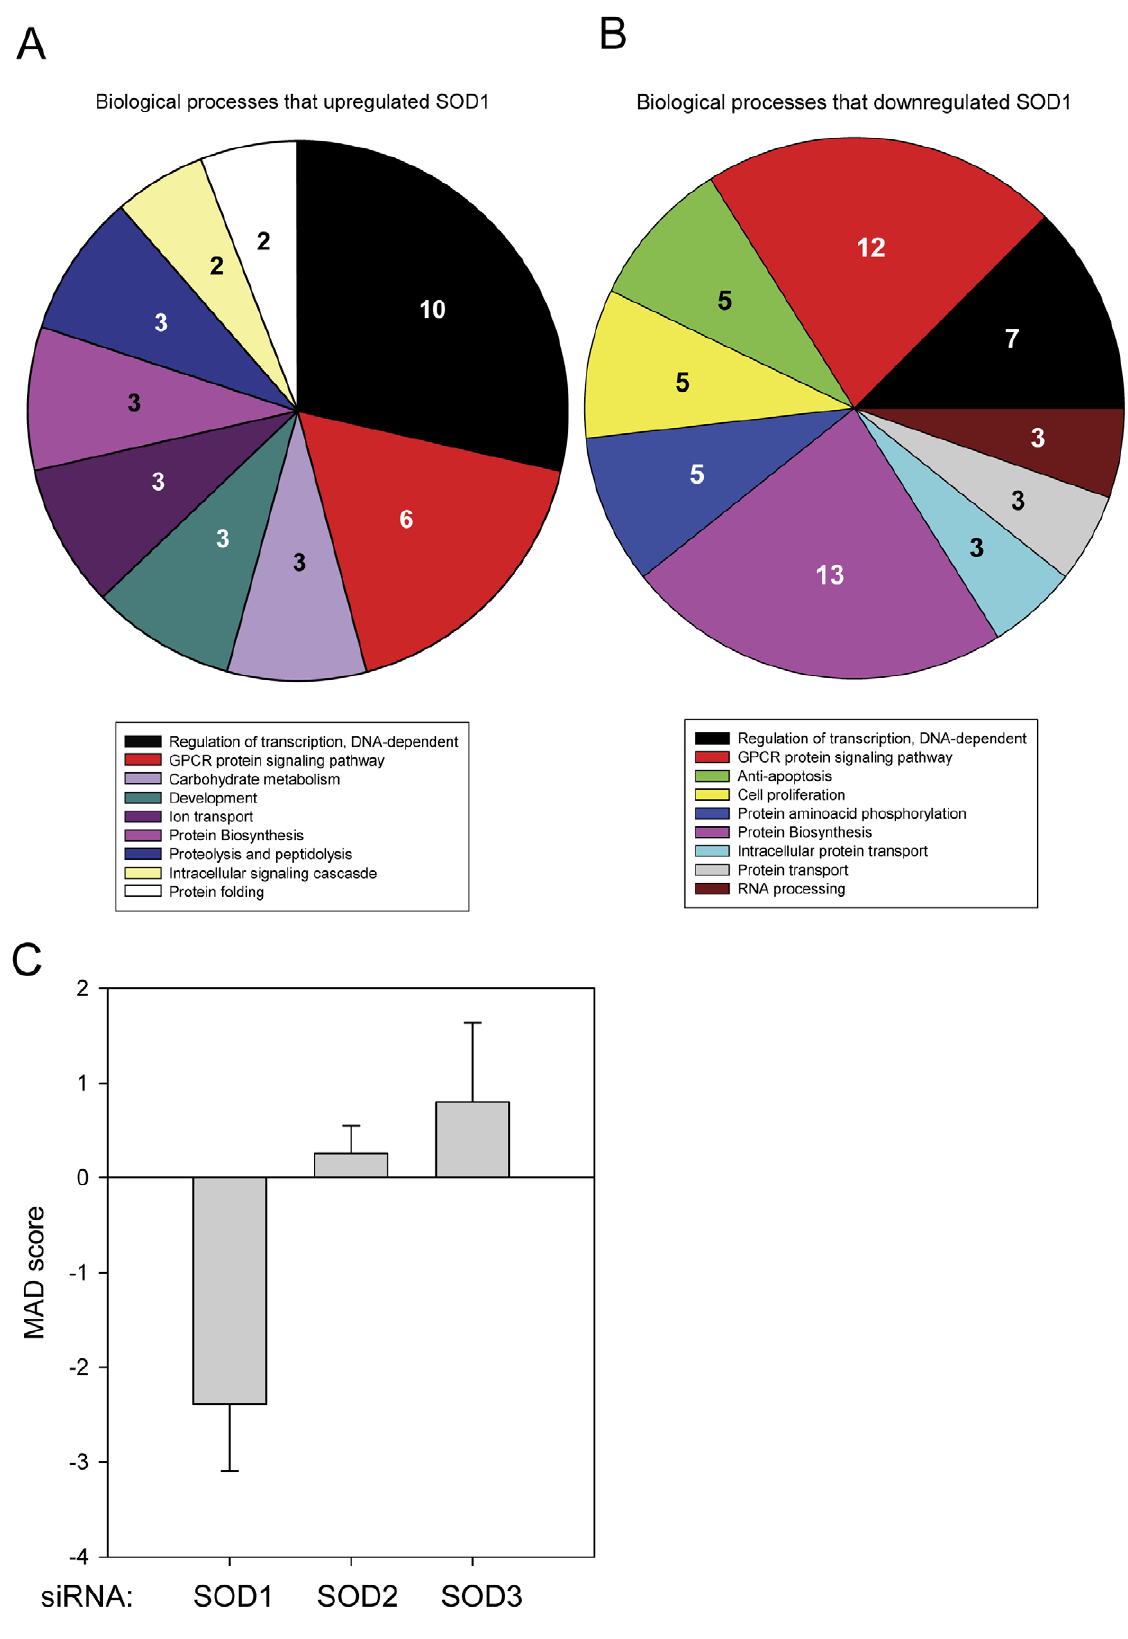
Figure 3. Classification of prominent regulators of SOD1 in the RNAi screen. A & B ) Pie charts representing annotated biological process of proteins identified as regulators of SOD1. Contribution of each biological process as a percentage of total are shown. Contributions of processes that